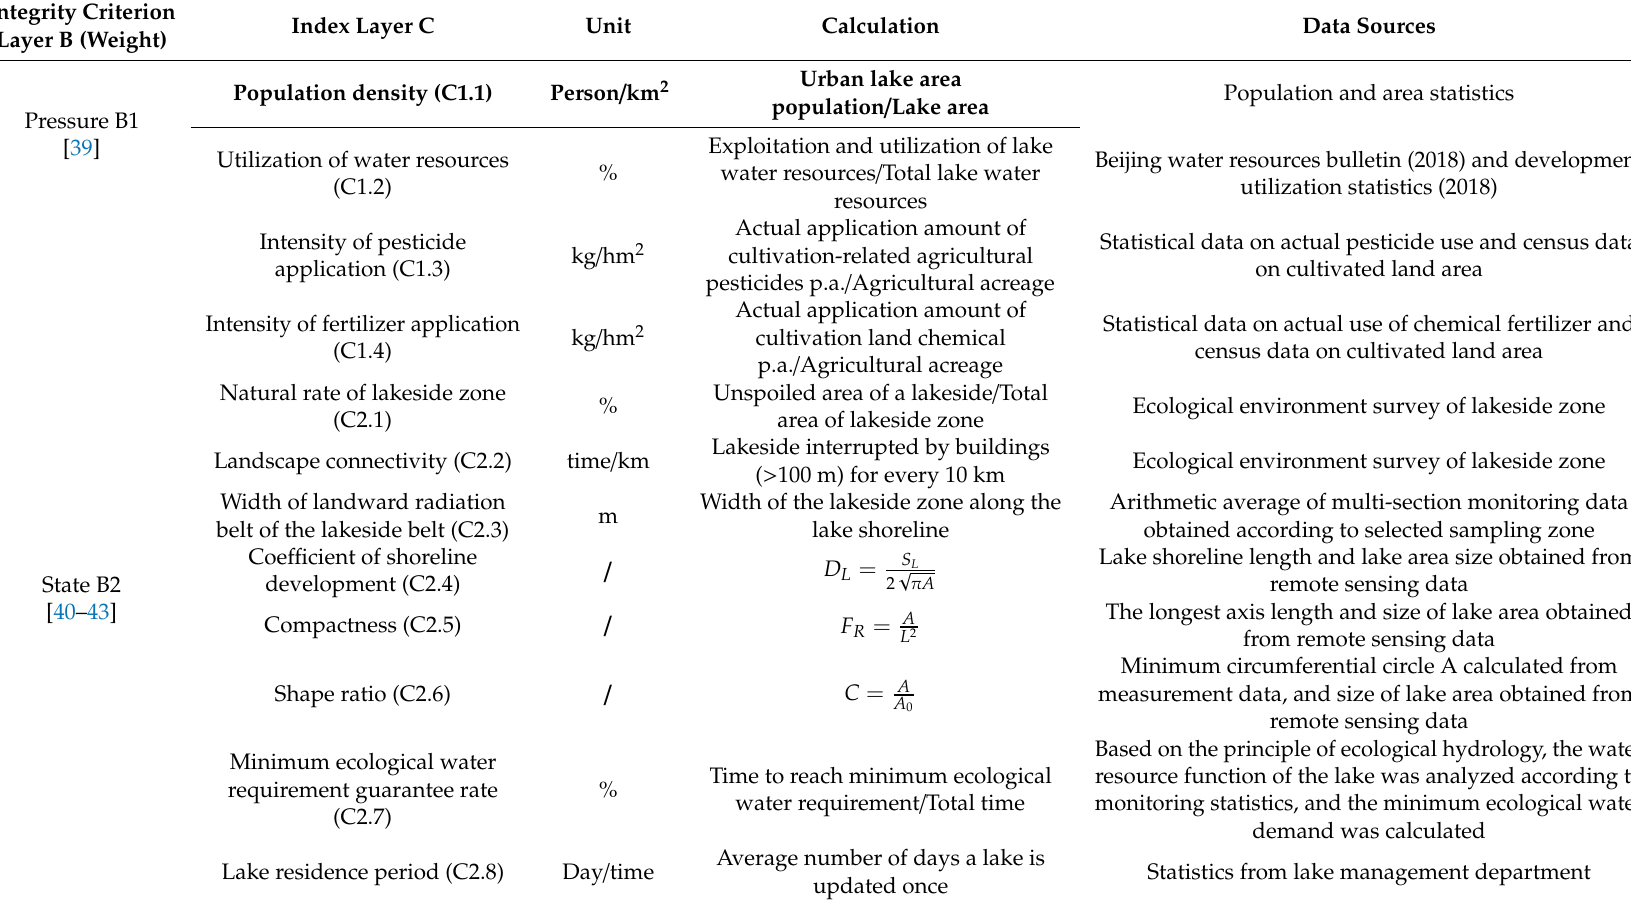
Table 2. Calculation methods of di ff erent indicators and related data